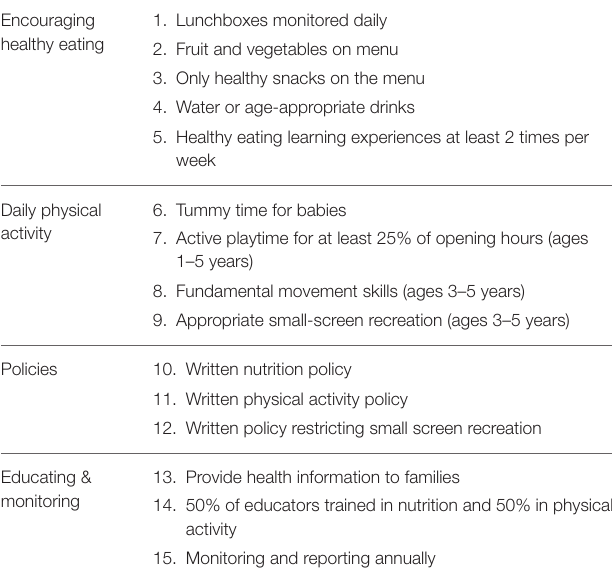
TABLE 1 | Program adoption indicators